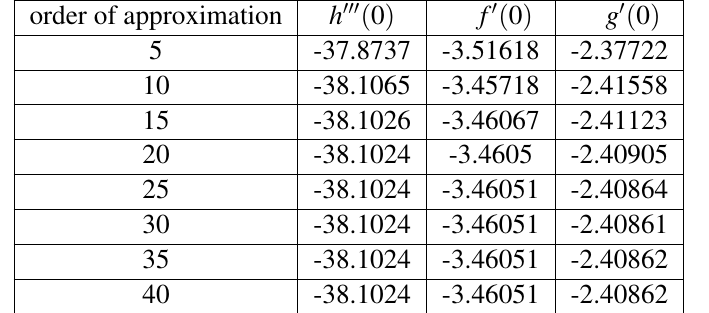
order of approximation